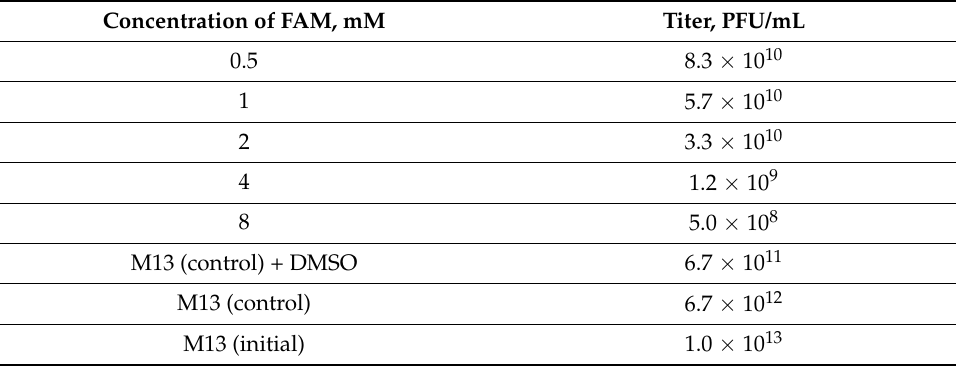
Table 1. The titers of modified and control phages M13 № 3.